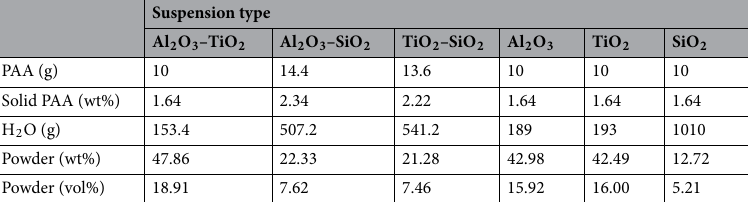
Table 2. PAA and powder concentrations on a per suspension basis. Note: PAA (g) refers to the solution of PAA. Solid PAA (wt%) is calculated with respect to the total mass of solid components in solution. The vol% and wt% refer to the powder in